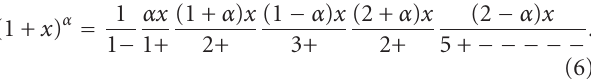
Figure 2: Pole-zero plot of